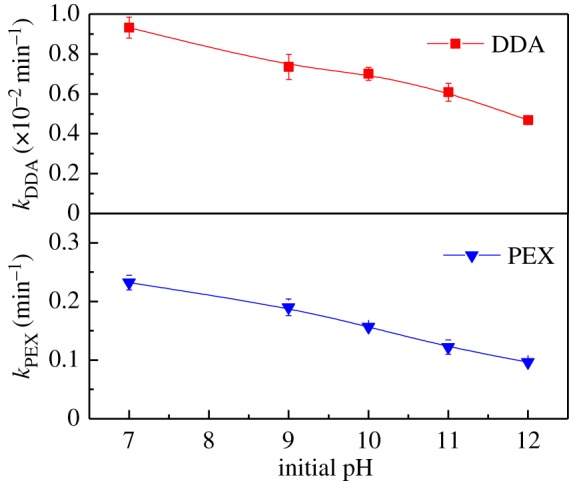
The variations of the kPEX and kDDA with initial pH under UV185+254 nm irradiation. Experimental conditions: collector concentration of 100 mg l−1.